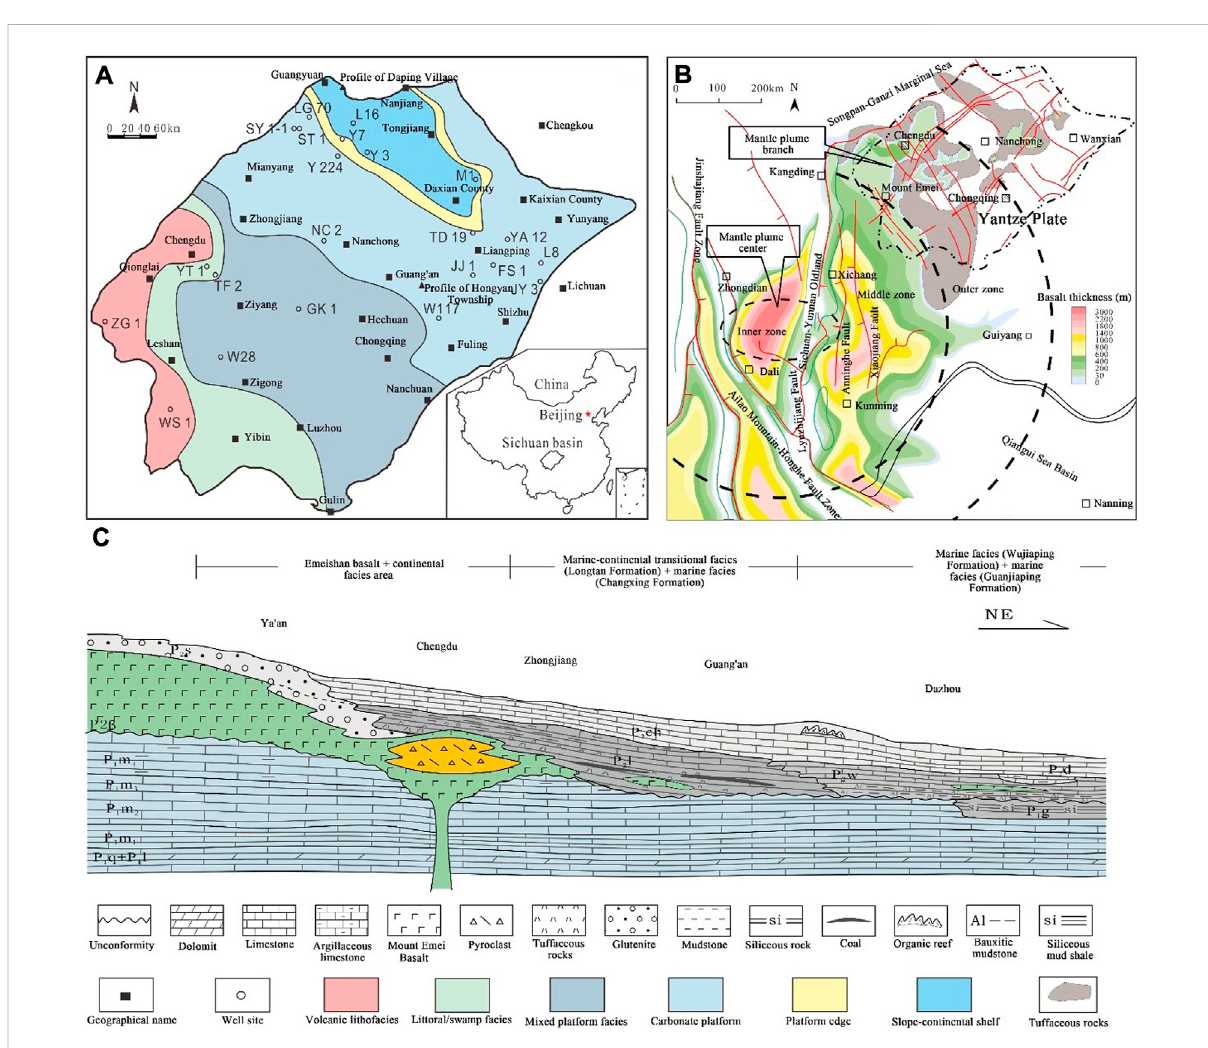
FIGURE 1 Sedimentary facies and distribution of tuffaceous rocks in the research area. (A) Sedimentary facies in the research Area; (B) Distribution of permian tuffaceous rocks in the research area; (C) Cross section of Permian in Sichuan